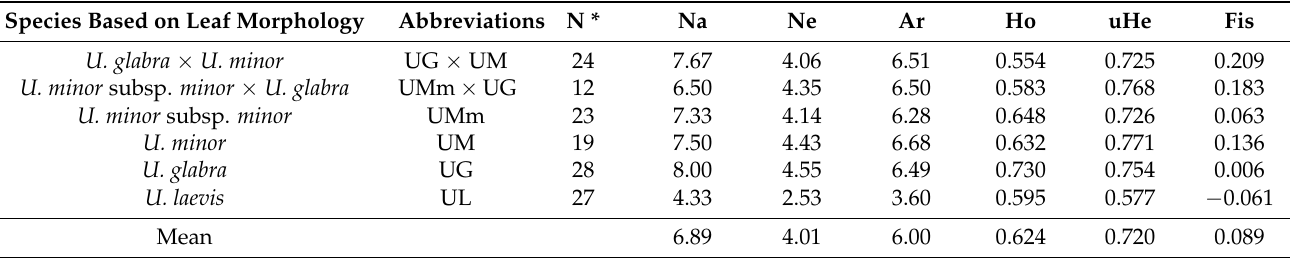
Table 4. The within-population genetic diversity parameters estimated based on six nSSR loci. Species Based on Leaf Morphology